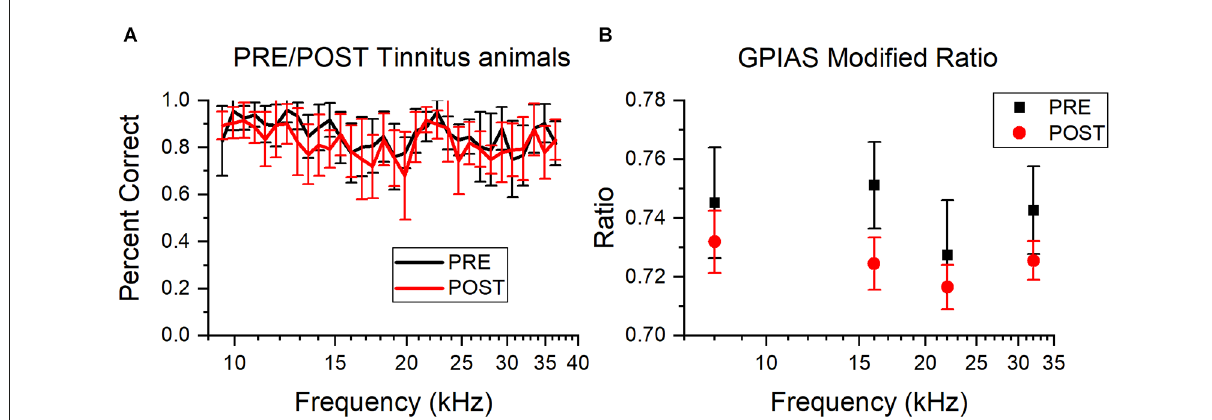
FIGURE6 Sound overexposure does not affect AA or GPIAS performance: Comparison of percent correct trials for AA and GPIAS testing PRE and POST soundoverexposure,plottedasmeanandstandarderror.PREisred,POSTisblack. (A) Averagepercentcorrectavoidancefornon-tinnitusanimals for all tested frequencies (kHz) PRE and POST. There are no significant changes between PRE and POST, but there is a small shift downwards for POST testing. PRE n = 14, POST n = 13. (B) Average modified ratio for non-tinnitus animals across all tested frequencies. There are no significant differences PRE and POST, but POST has slightly smaller ratios. PRE n = 9, POST n =